Question: What caption would you write for this figure?
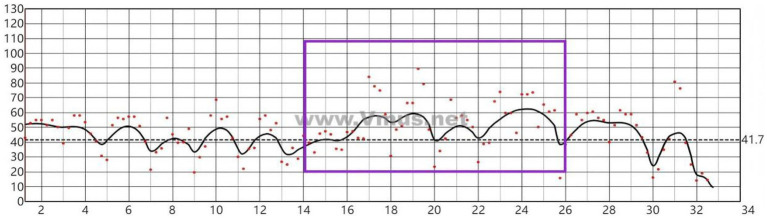
Answer: Yin Chengzong Macro Tempo Curve.